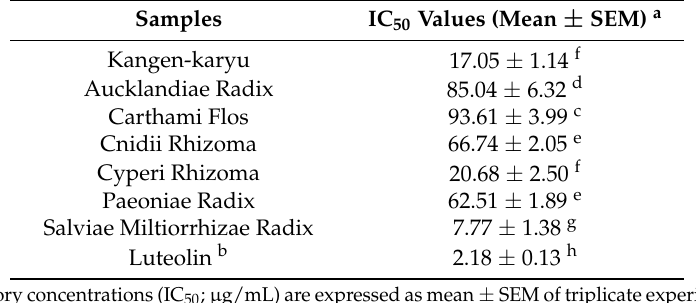
Table 1. Glycogen synthase kinase-3 β inhibitory potentials of water extracts of Kangen-karyu and its constituents.